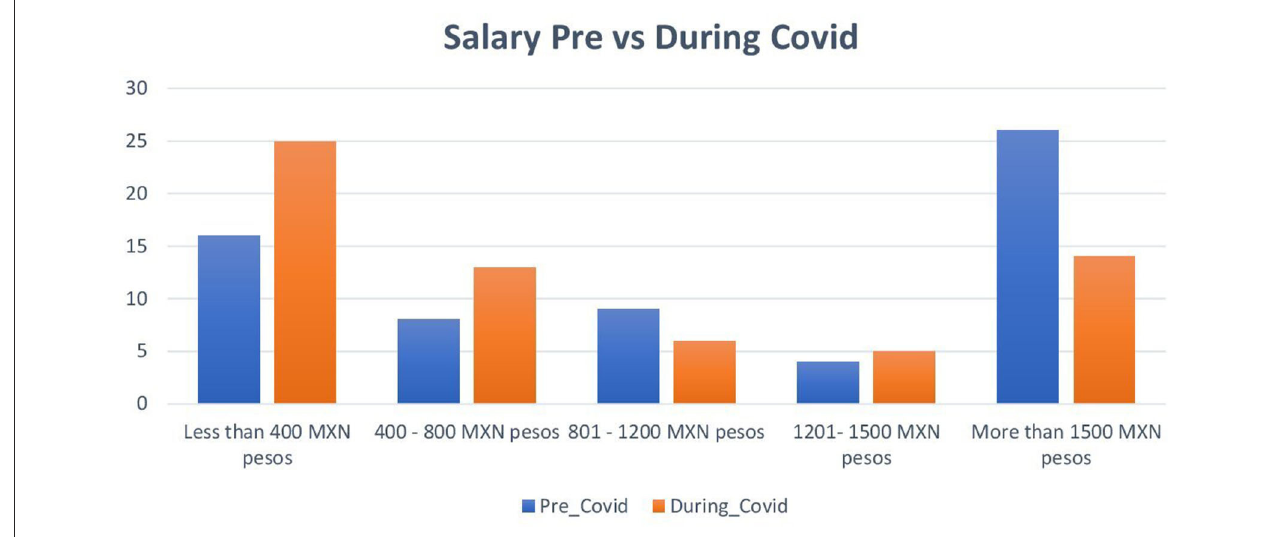
FIGURE1 Monthly income before and during COVID-19 (March